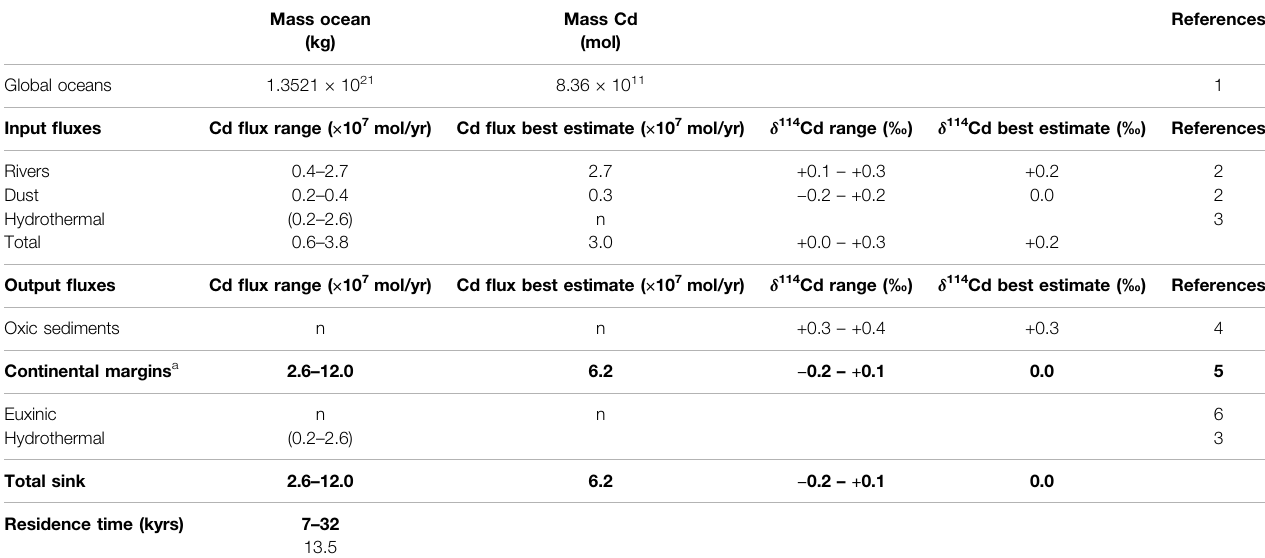
TABLE 4 | Oceanic Mass Balance of Cd from published data and data presented in this